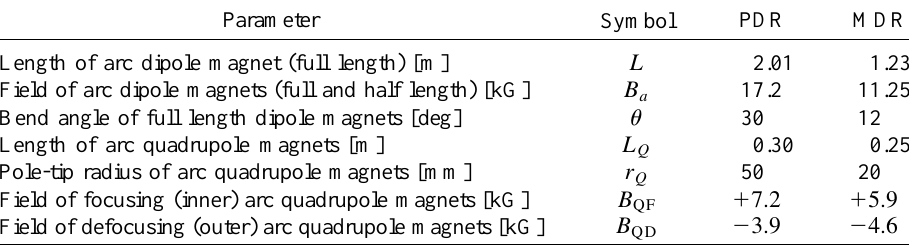
TABLE III. List of various magnet parameters in the NLC MDR and PDR. Parameter